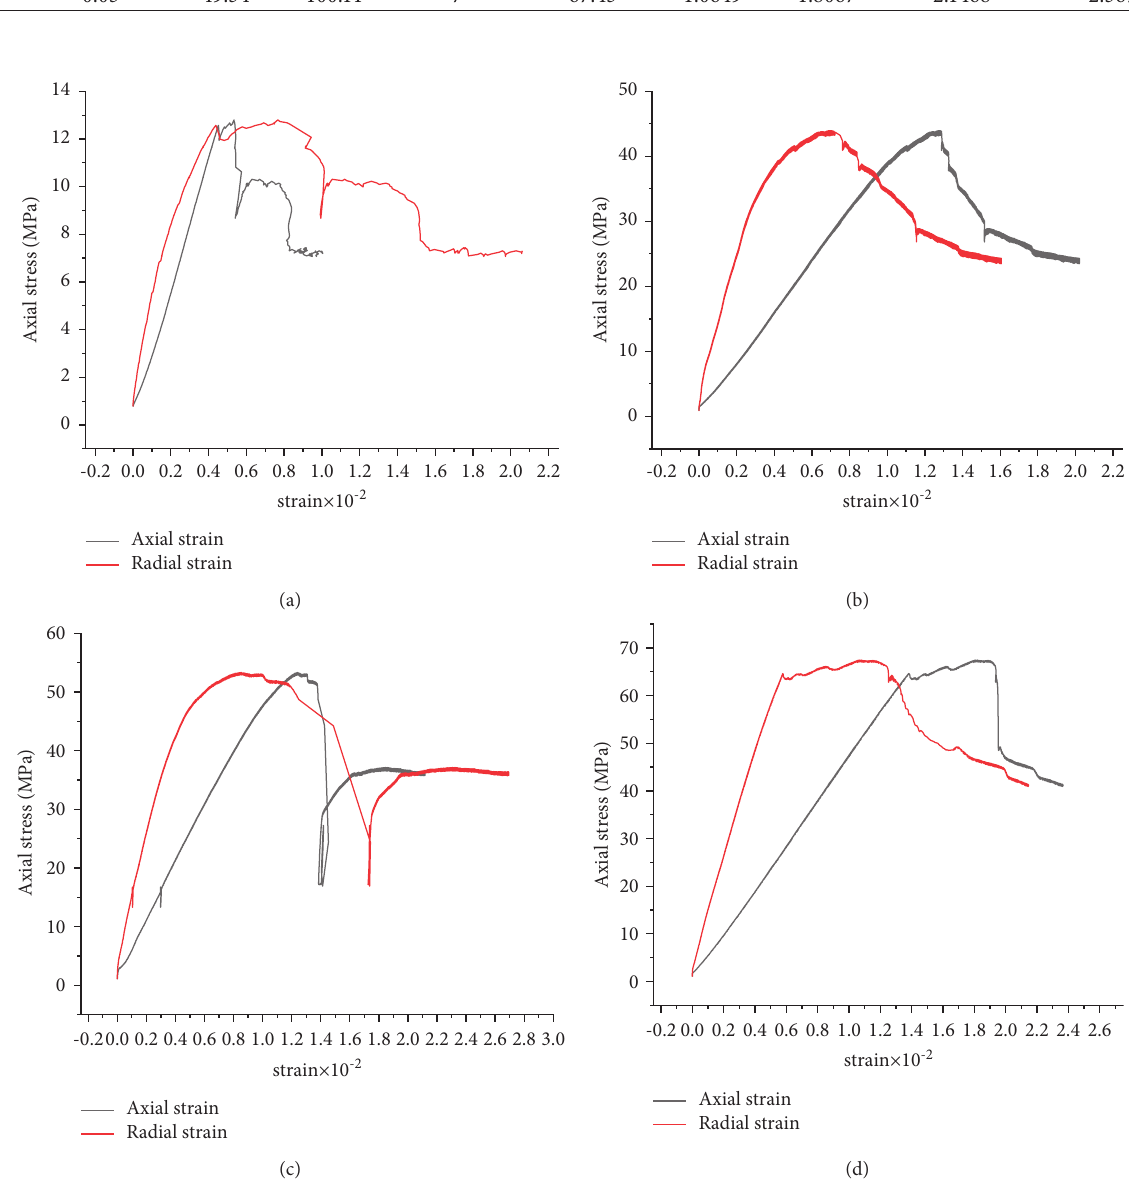
Figure 4: Stress-strain curves under different confining pressures. Stress-strain curve under (a) 0 MPa confining pressure, (b) 3 MPa confining pressure, (c) 5 MPa confining pressure, and (d) 7 MPa confining